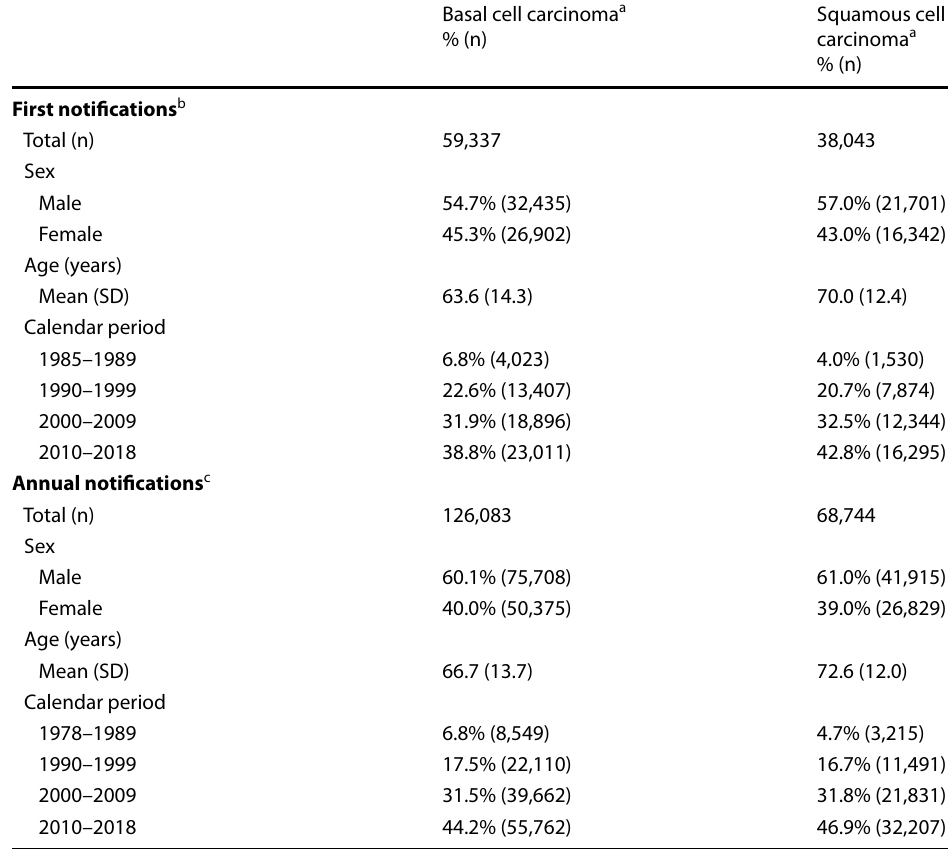
Table 1 Characteristics of the study